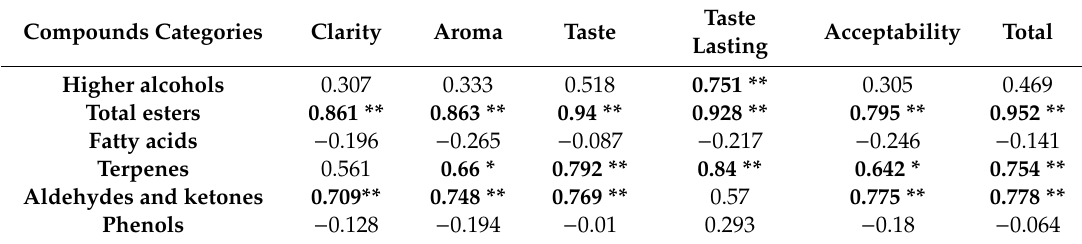
Table 5. Correlation analysis between sensory evaluation scores and aroma